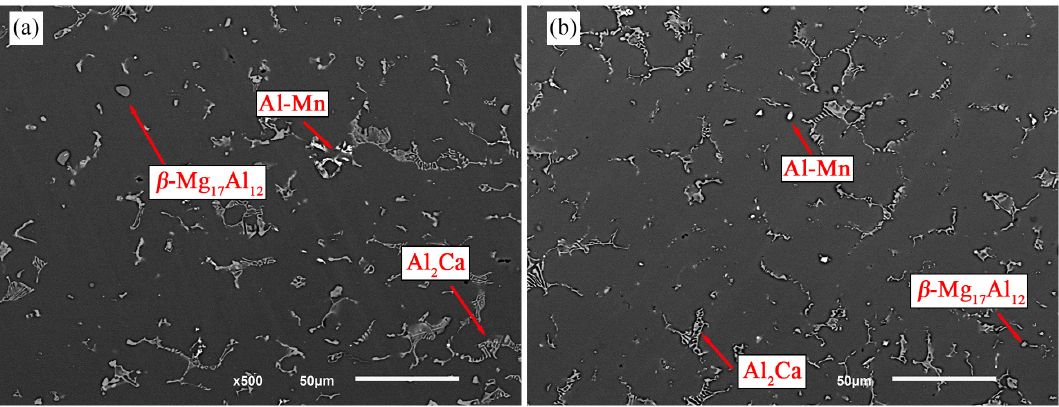
Figure 2. Microstructure of ( a ) non- and ( b ) US-treated samples after solution treatment at 415 °C for 480 min.